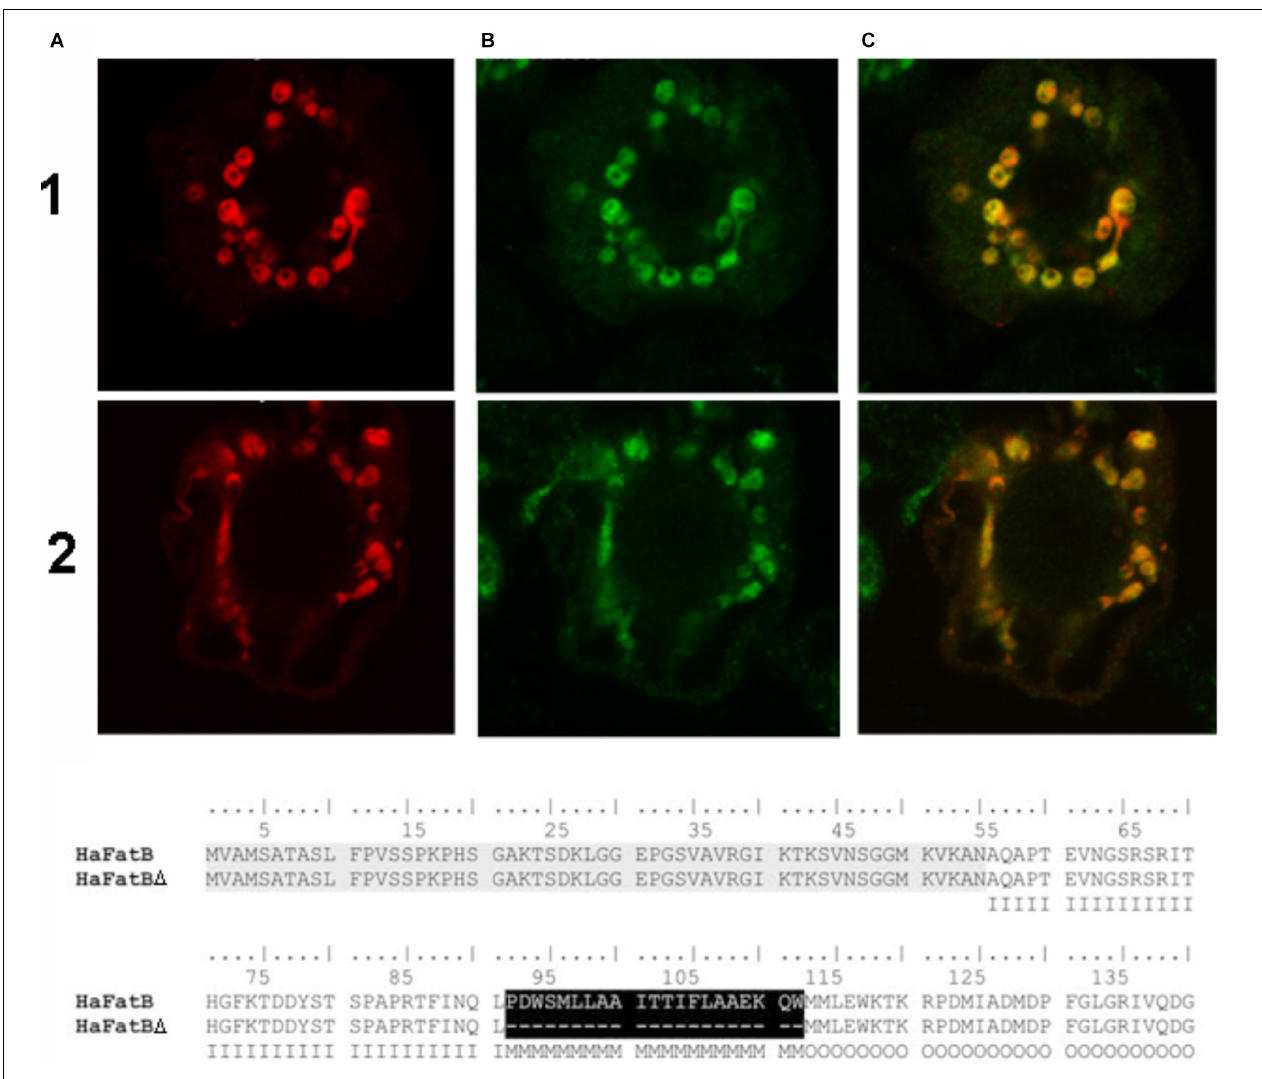
FIGURE 8 | Representative confocal laser scanning microscopy images images of Cherry-tagged Ha FatB-Cherry or Ha FatB (cid:49) Cherry expressed transiently (via biolistic bombardment) in BY-2 tobacco cells. Images in column (A) show FatB-Cherry row (1) and FatB (cid:49) -Cherry row (2) , while those in column (B) represent fluorescent Alexa 488 dye-conjugated to Anti-N-acetyl glutamate kinase (Anti NAGK). The corresponding merged images of all the cells are shown in column (C) . The amino acid alignment of sequences corresponding to Ha FatB and the mutant Ha FatB (cid:49) , highlighting the hydrophobic region removed in black. This hydrophobic region was localized using different bioinformatics programs and it was removed by PCR splicing using the sequence of Ha FatB. The first 50 amino acids correspond to the signal peptide: I, Inside amino acid; M, transmembrane helix amino acid; O, outside amino